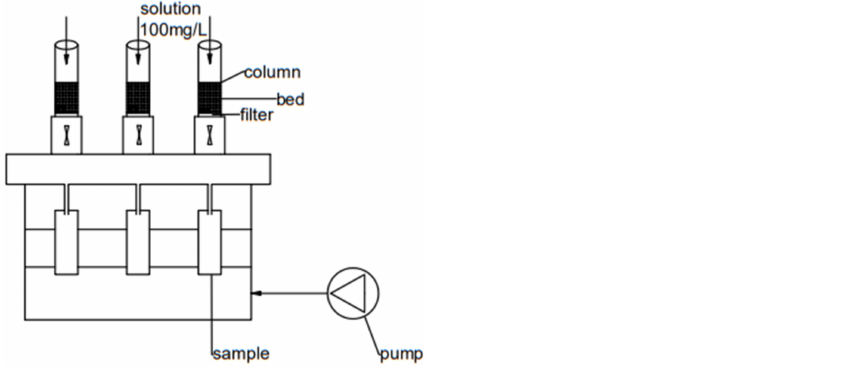
Figure 1. Scheme of the column system used for mercury sorption on prepared